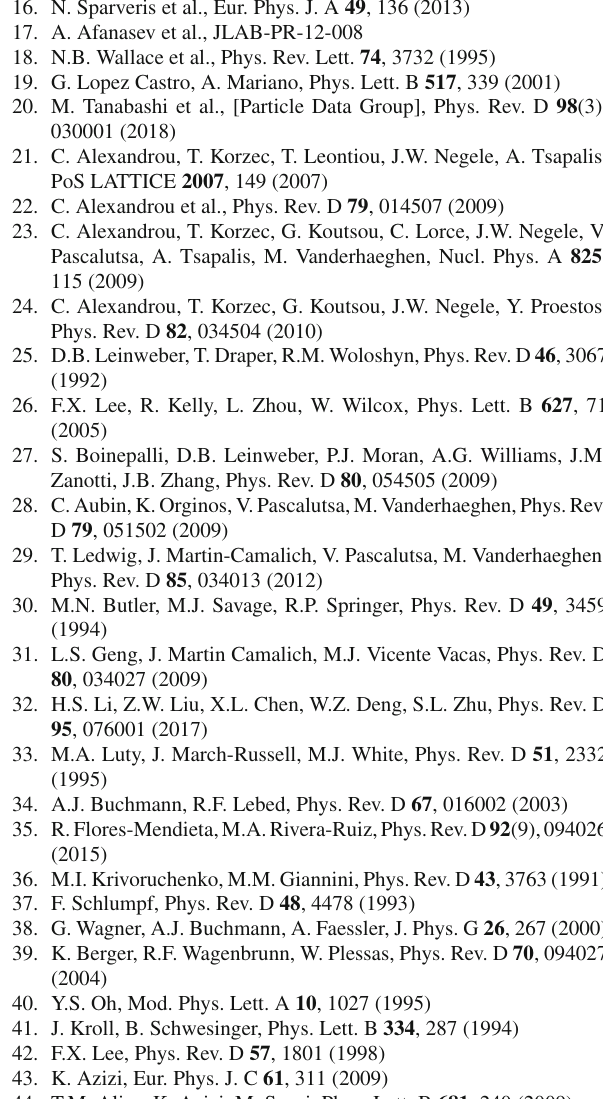
Fig. 15 Magnetic dipole form factors of the baryon decuplet in comparison with those of the nucleon